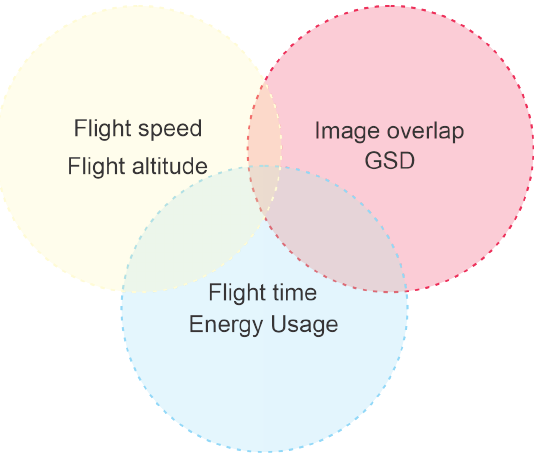
Figure 8. Conflicting optimization goals.